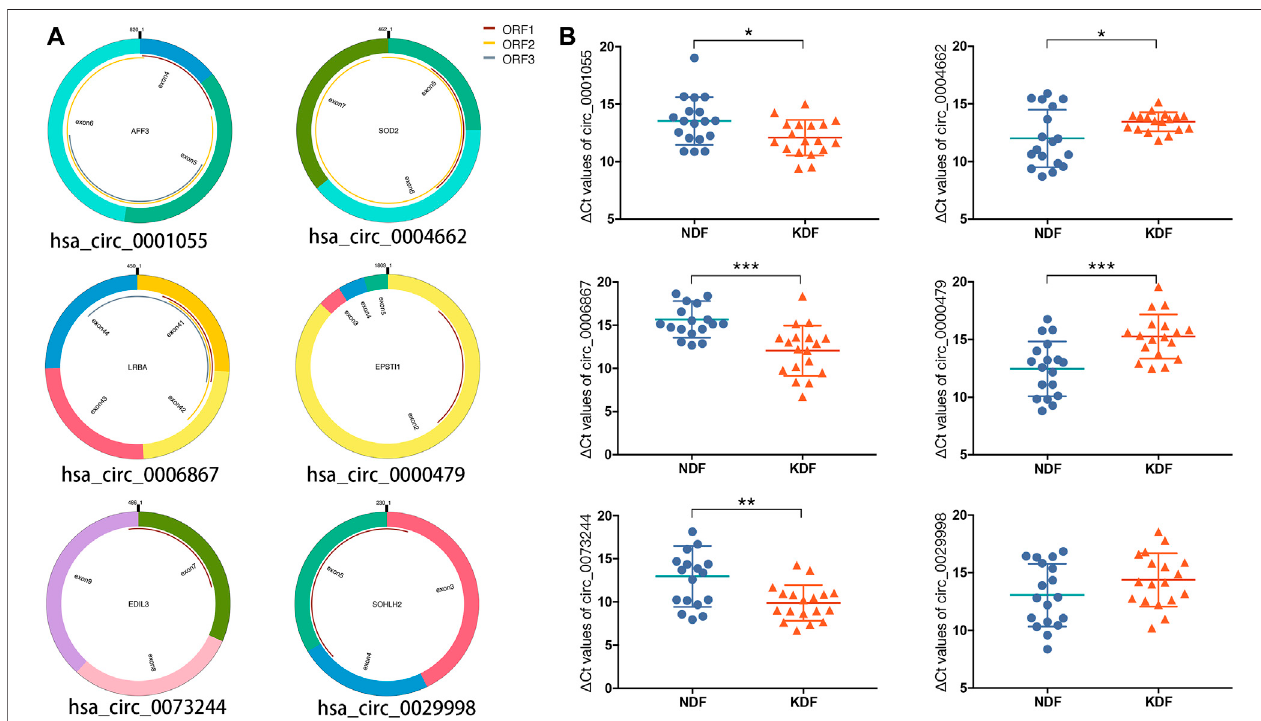
FIGURE 5 | Characteristics and veri fi cation of six candidate circRNAs. (A) Structural patterns and (B) qRT – PCR results of upregulated circRNAs (left), including hsa_circ_0001055, hsa_circ_0006867, and hsa_circ_0073244, as well as three downregulated circRNAs, including hsa_circ_0004662, hsa_circ_0000479, and hsa_circ_0029998.